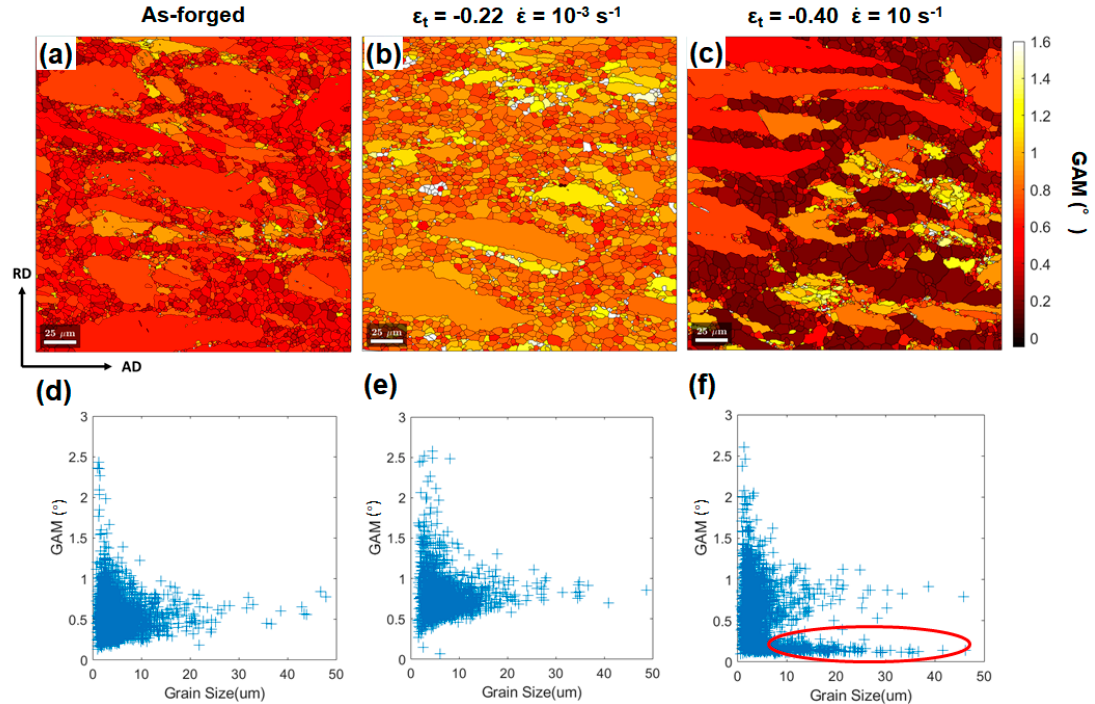
Figure 7. GAM maps for the microstructures in: ( a ) the as-forged state, deformed state with ε t of − 0.40 . ε . ε ( b ) at of 10 s − 1 and ( c ) at of 10 − 3 s − 1 . The corresponding plots of grain size versus the GAM value are plotted in ( d – f ). The yellow ellipse in ( f ) highlights the occurrence of grown equiaxed grains with low GAM value and large grain size.